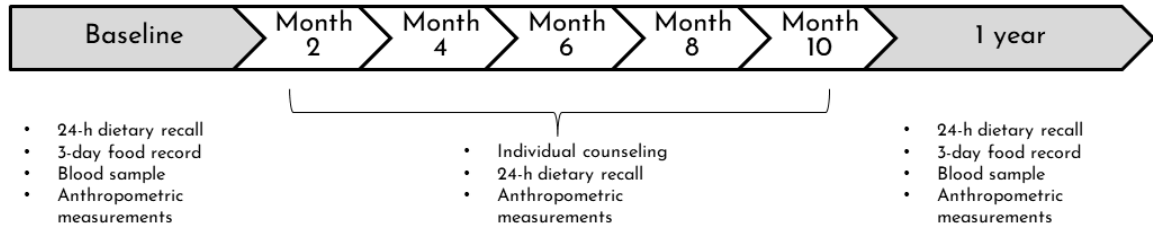
Figure 1. Design of the nutritional intervention of the VIE project. The intervention consisted of an initial assessment, follow-up visits planned every two months for one year, and a one-year assessment.